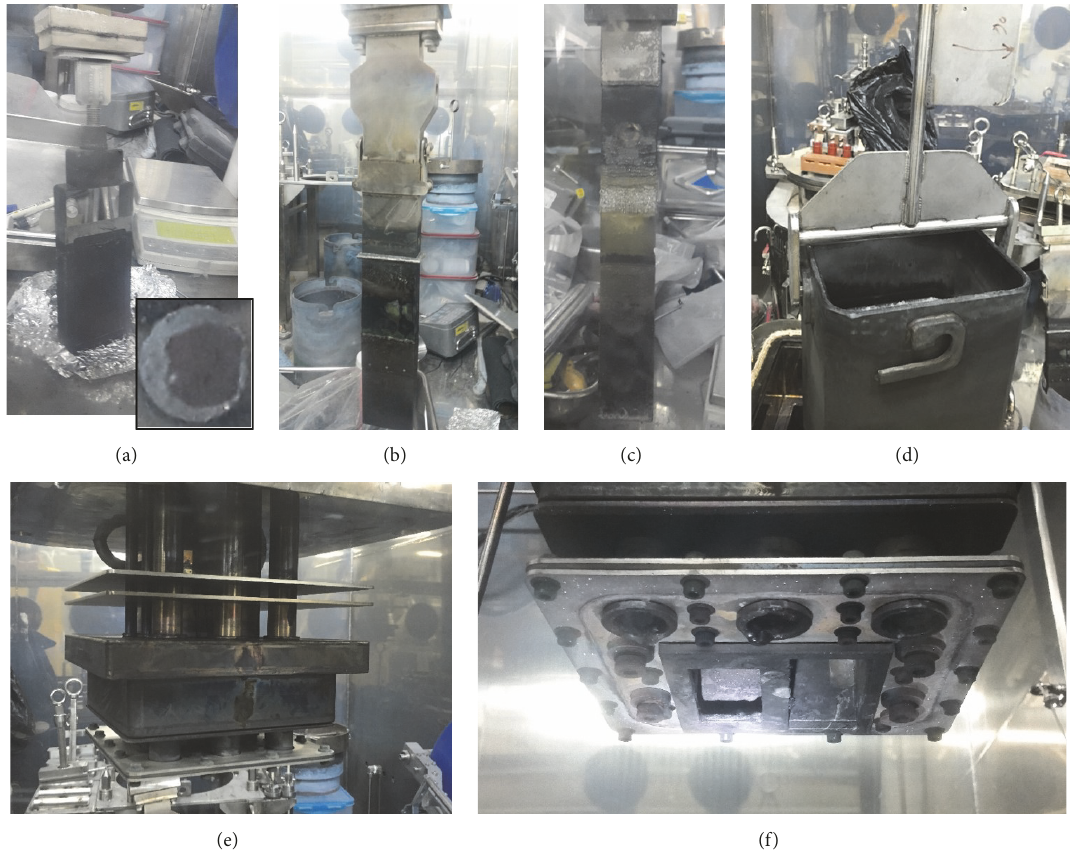
Figure 5: Photographs after electrolysis: (a) cathode (inset: reduction products); (b) anode shroud; (c) Pt anode and its electrical conductor; (d) inner crucible containing the salt; (e) side view of the top flange; and (f) bottom view of the top